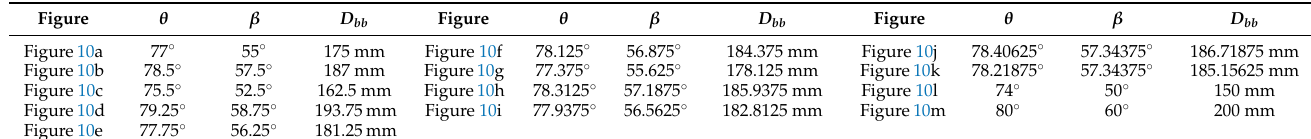
Table 2. List of the values of the Wind Booster parameters used by the bisection algorithm.